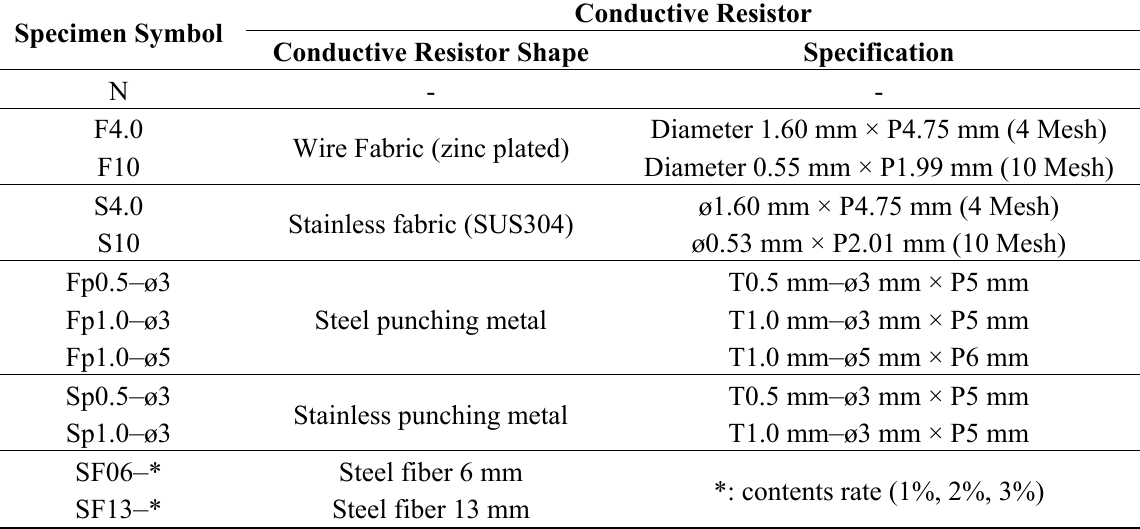
Table 2. Experimental factors for evaluation of assembly